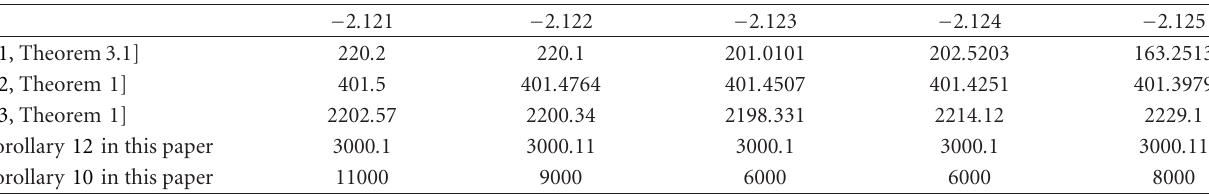
Figure 3: State responses of the closed-loop system when h 3 = 0 . 15. Table 1: Allowable upper bound of τ M for di ff erent β